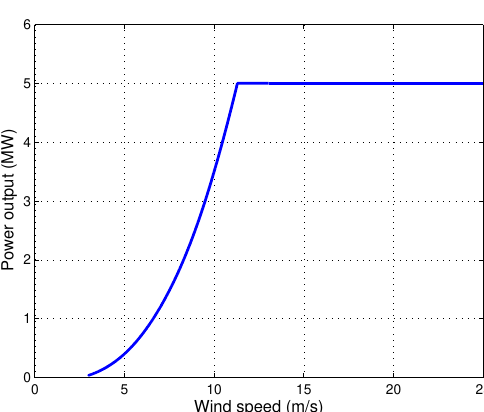
Figure 2. Wind turbine static model.